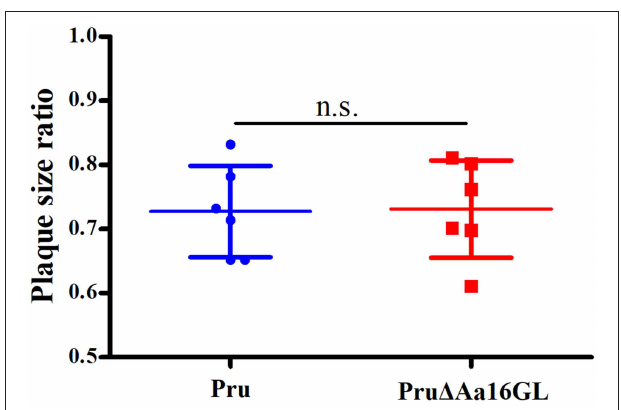
FIGURE 5 | Effect of external carbon sources on Toxoplasma gondii growth. Parental Pru strain or Pru 1 Aa16GLstrain treated with regular DMEM or carbon source-free medium for 6h were allowed to infect HFF monolayers under normal conditions for 9 days. Samples were fixed and the plaque sizes were determined. n.s, not significant, Student’s t